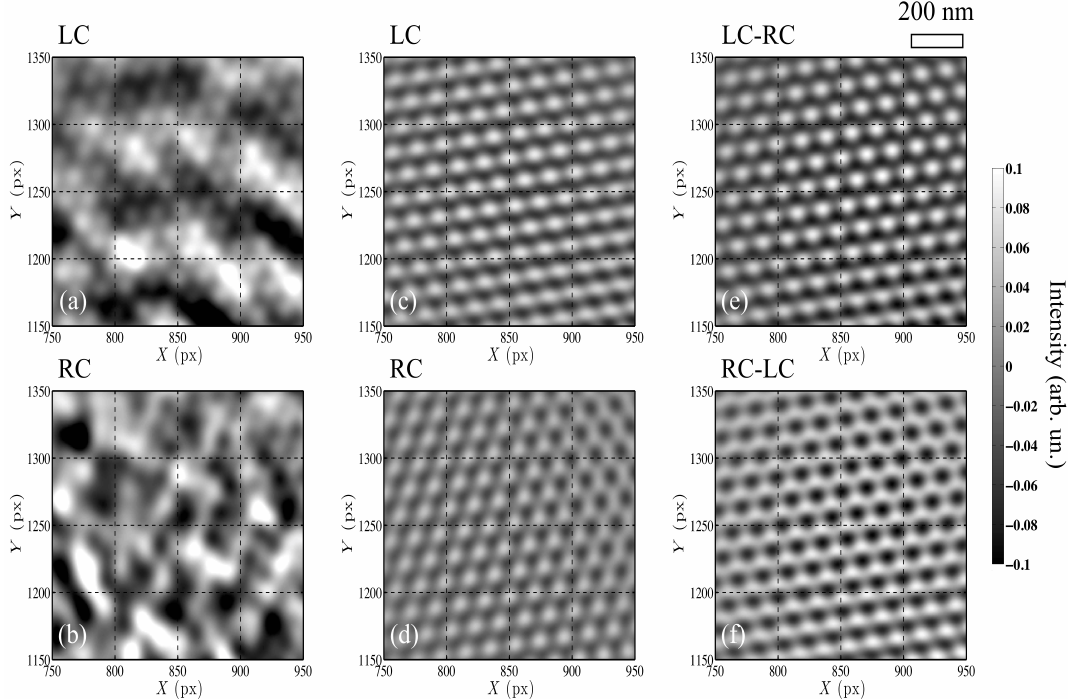
Figure 5. Magnification of the real-space image of the skyrmion lattice obtained by the iterative phase retrieval. Patterns shown in panels ( a , b ) are reconstructed from the square root of the original RSXS data obtained with left circular (LC) and right circular (RC) soft X-ray polarizations, respectively; ( c ) Real-space reconstruction of the LC and ( d ) RC datasets were processed as described in Section 2.2; ( e ) Difference of left and right polarized reconstructed images (LC-RC) and ( f ) right and left (RC-LC) reconstructions showing the contrast inversion for opposite polarizations. The axis values are given in pixels for the convenient determination of the positions of the